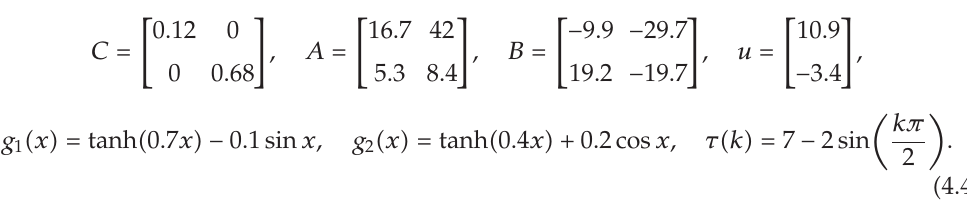
Figure 1 that the chaos behaviors have appeared for neural network (cid:2) 2.1 (cid:3) with above given